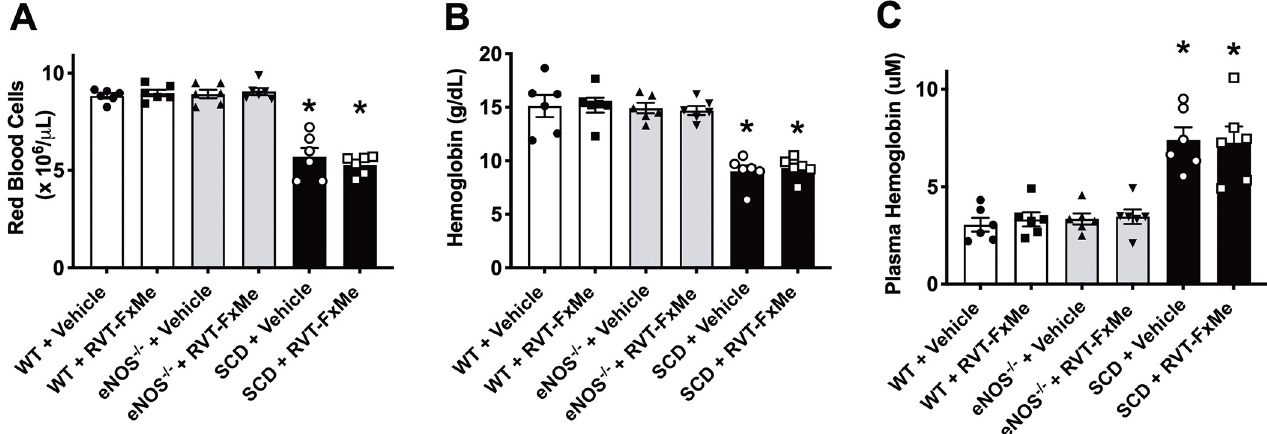
Fig 2. Hematological parameters of WT, eNOS -/- and SCD mice treated with RVT-FxMe (25 mg/kg/day, 2 weeks) or vehicle. Data are shown as mean ± SEM of 6 mice per group. (A) Red blood cell, (B) hemoglobin and (C) plasma hemoglobin. One-way ANOVA: � P < .05 vs WT group.